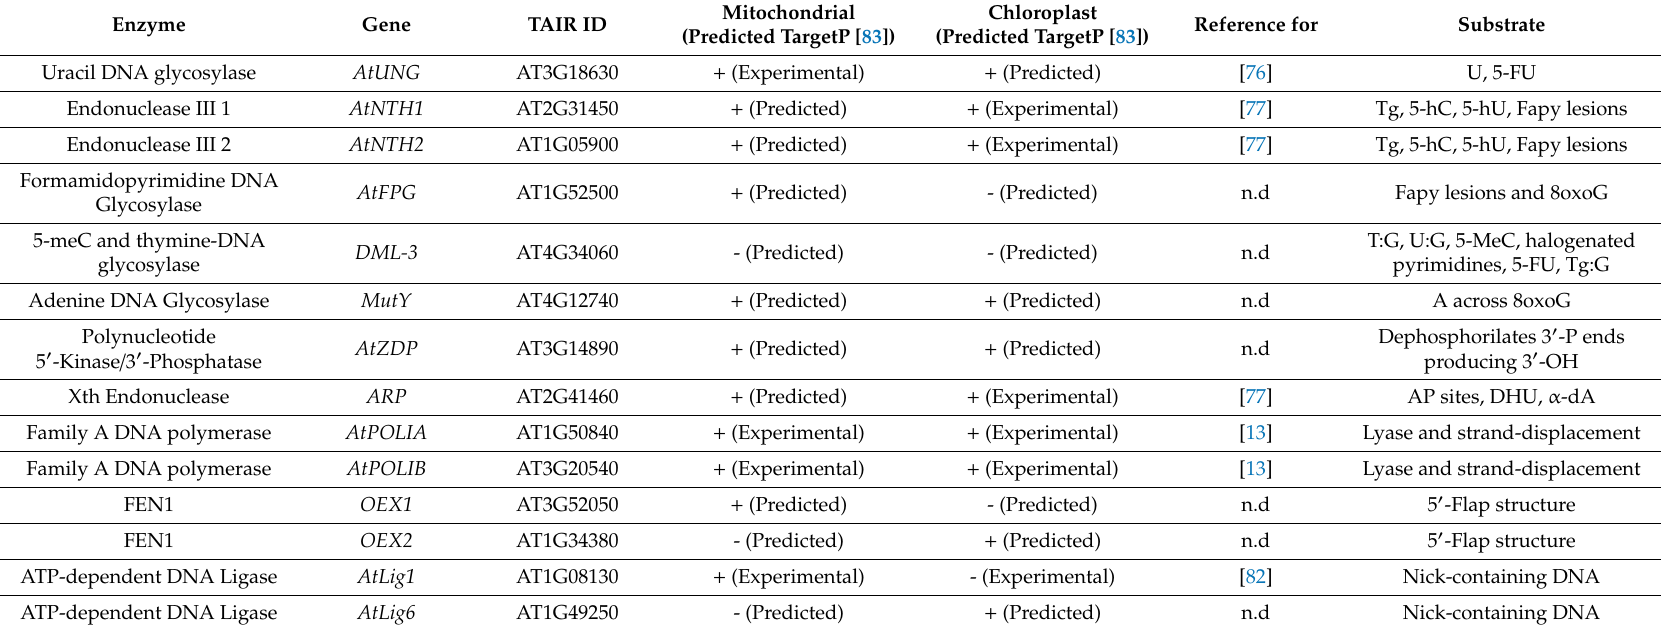
Table 2. Base Excision Repair proteins present in mitochondria and chloroplasts in A. thaliana